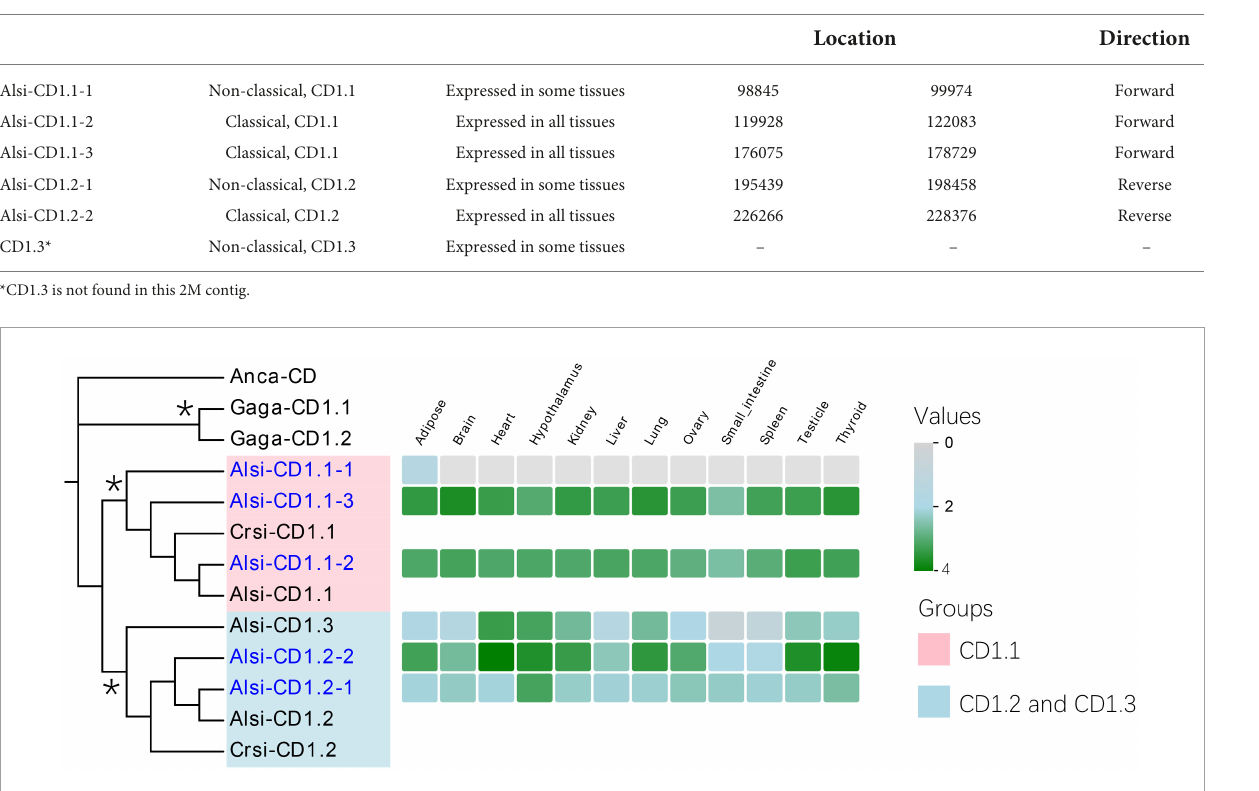
FIGURE7 Phylogenic evolution and expression of CD1.1 genes in the Chinese alligator. The significant clades are marked with different colors (purple-CD1.1 and blue-CD1.2 and CD1.3). Explanatory notes are the same as in Figure 5 . Stars on phylogenetic trees suggest bootstrap values > 0.7.